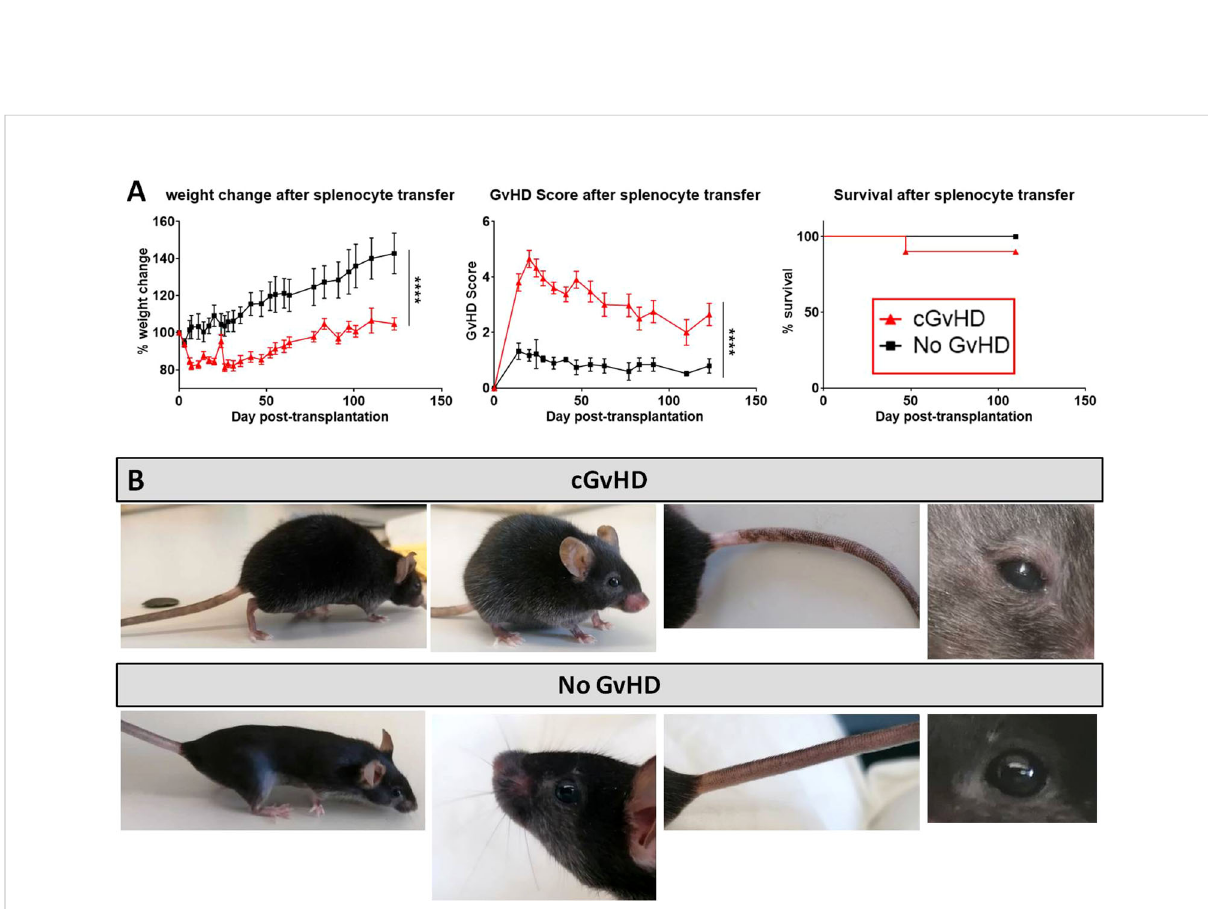
FIGURE 3 cGvHD morbidity and mortality over 125 days in C57BL/6 ! BDF1. (A) Clinical cGvHD was estimated by frequently assessing weight change (left), GvHD score (middle) and survival (right). Animals were regularly scored for fi ve clinical parameters (weight loss, posture, activity, fur and skin) on a scale from 0 to 2. Clinical GvHD score was summarized of all fi ve parameters. Error bars show mean ± SEM. n=10 per group. Representative data from one out of four experiments. ****P<0.0001 by unpaired students t-test. Survival was tested by Mantel-Cox-log-rank test. (B) Frequently observed clinical manifestations of cGvHD in BDF1-recipients (upper): Kyphosis, ruf fl ed fur, alopecia, skin-depigmentation and blepharitis were seen in allo-transplanted animals, while syn-mice did not show any cGvHD-symptoms